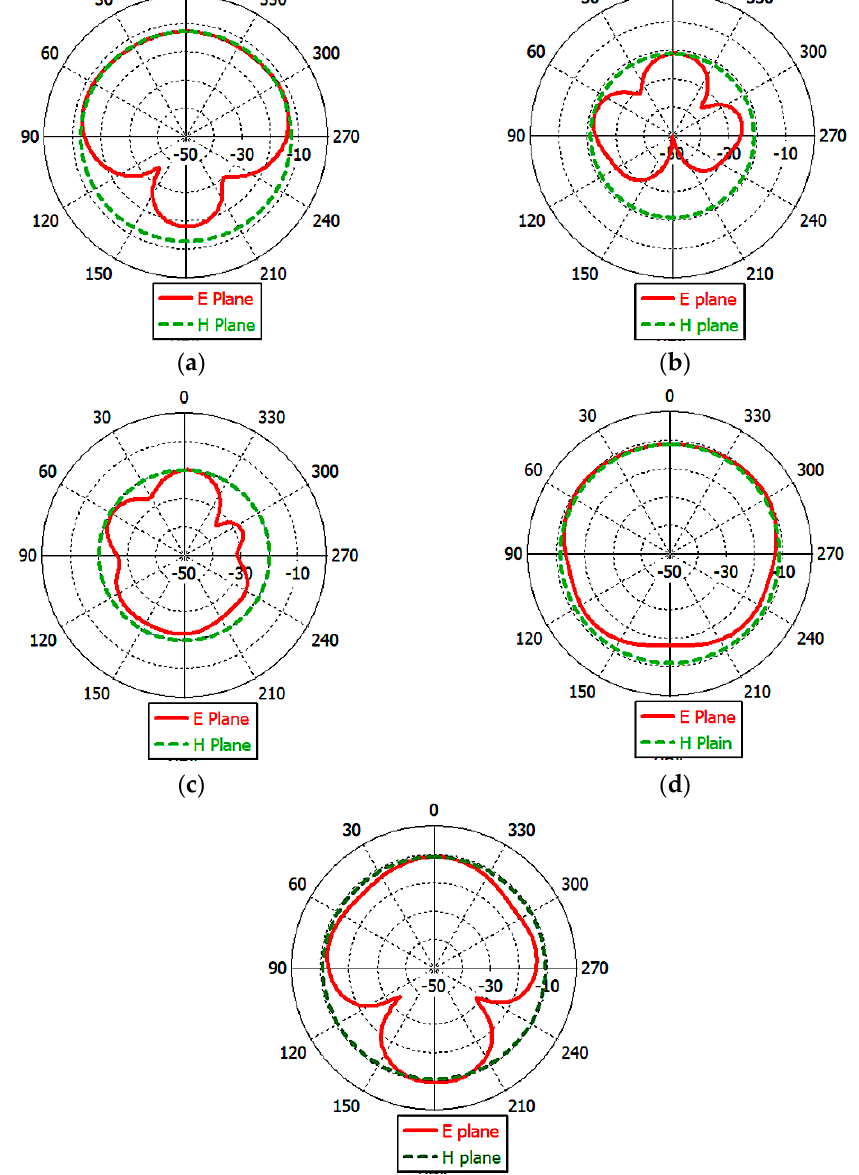
Figure 13. Radiation patterns of the proposed antenna at 2.45 GHz in the different scenarios: ( a ) muscle; ( b ) kidney; ( c ) liver; ( d ) brain; ( e ) skin.